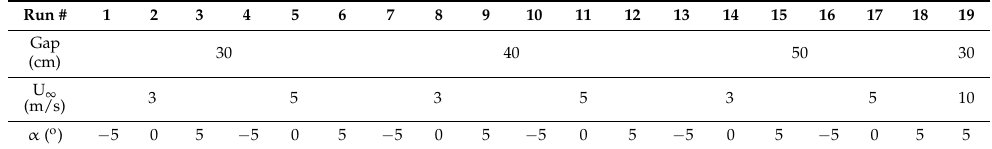
Table 2. Boundary conditions of simulations.